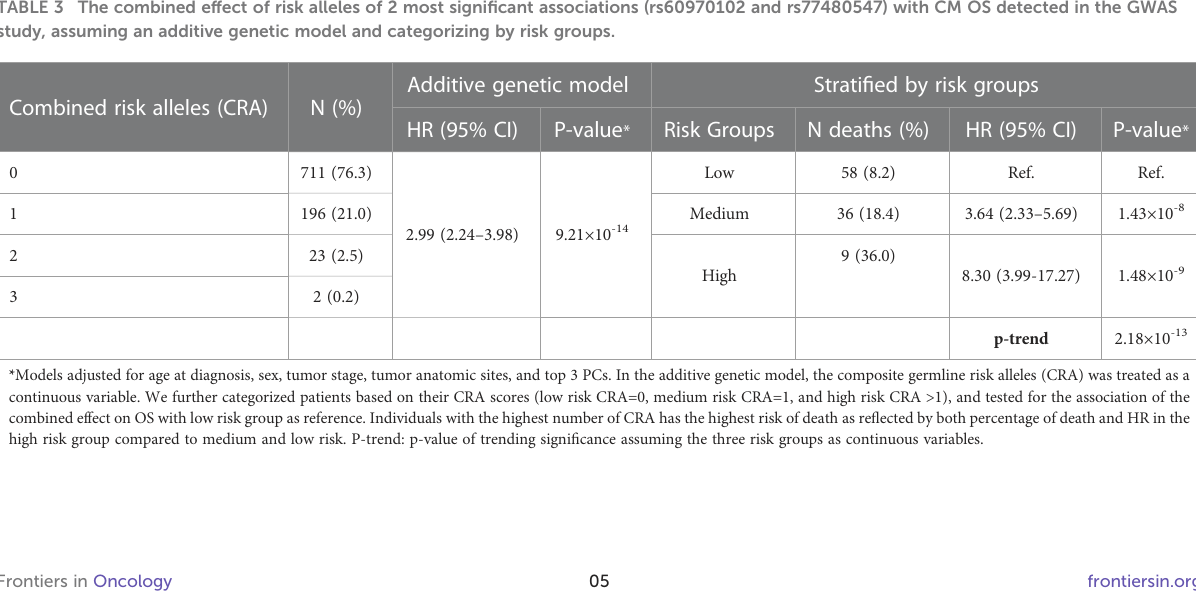
TABLE 3 The combined effect of risk alleles of 2 most signi fi cant associations (rs60970102 and rs77480547) with CM OS detected in the GWAS study, assuming an additive genetic model and categorizing by risk groups.